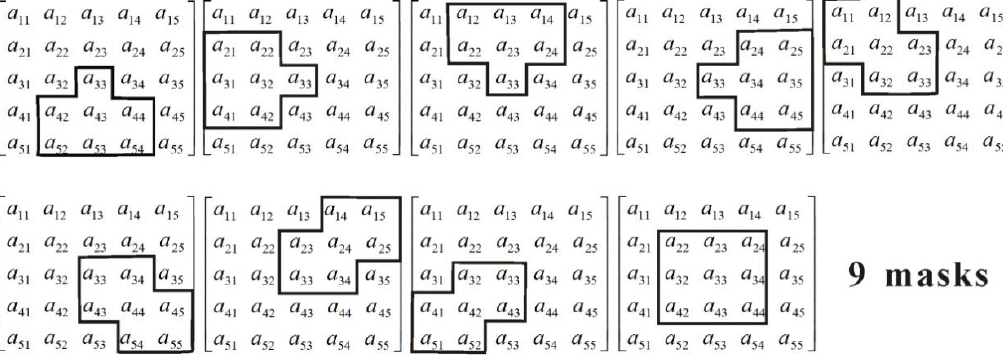
Figure 5. The adaptive filter algorithm.